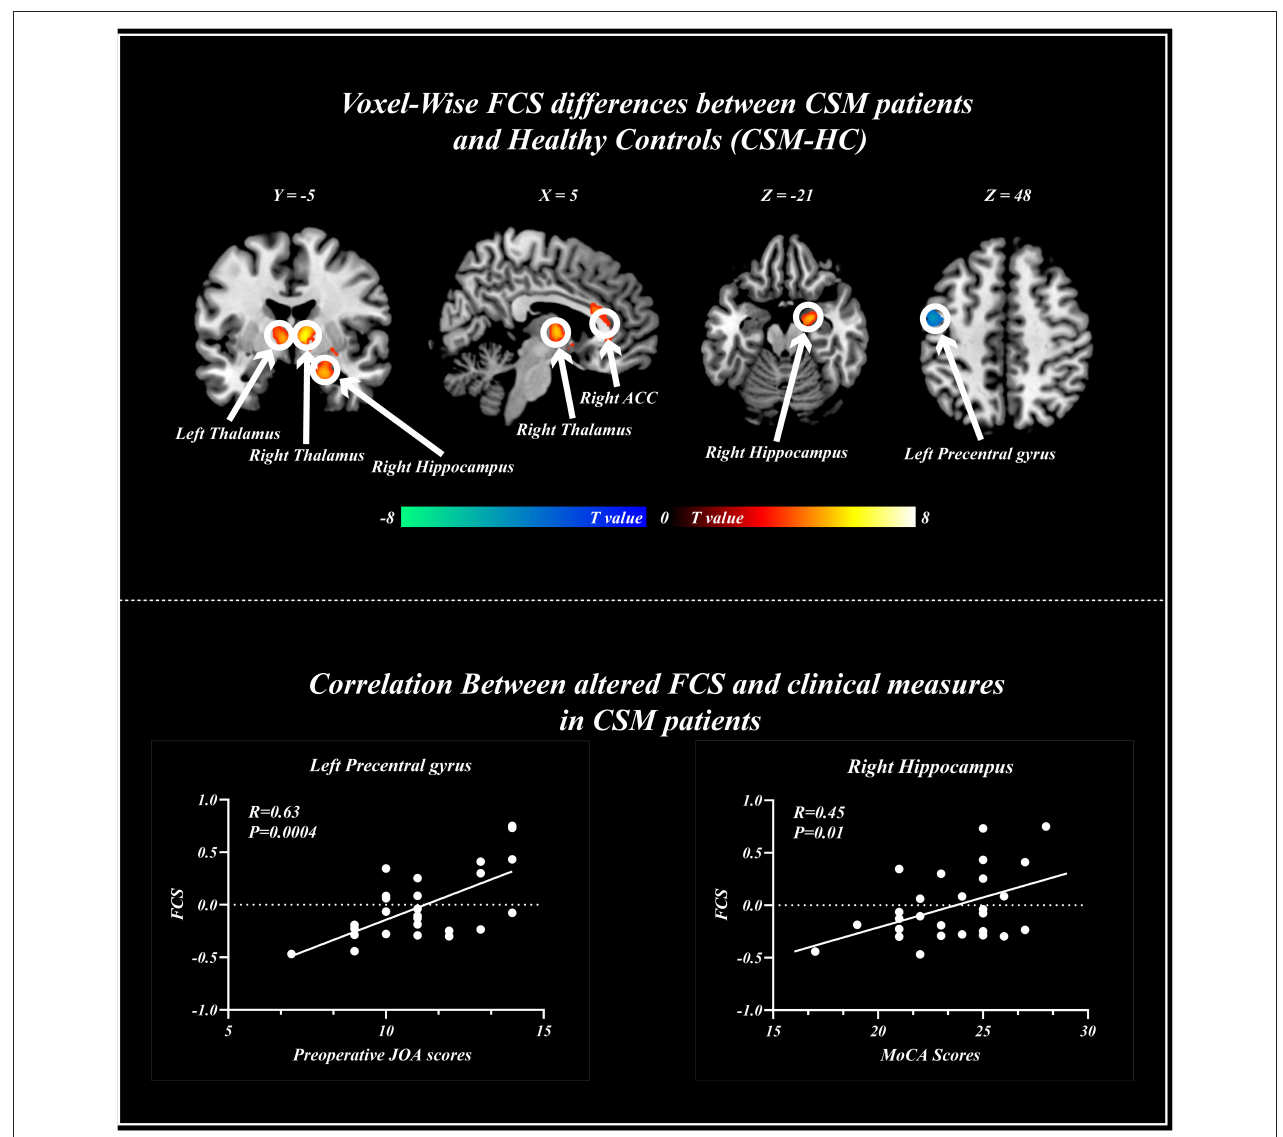
FIGURE 4 | Voxel-wise functional connectivity strength (FCS) changes in cervical spondylotic myelopathy (CSM) patients and healthy patients. Significant difference in FCS was found between the two groups. Scatter plots for the relationship between altered FCS and clinical measures including Montreal cognitive assessments (right), and preoperative Japanese Orthopedics Association scores (Left) across voxels. FCS, functional connectivity strength; ACC, anterior cingulate